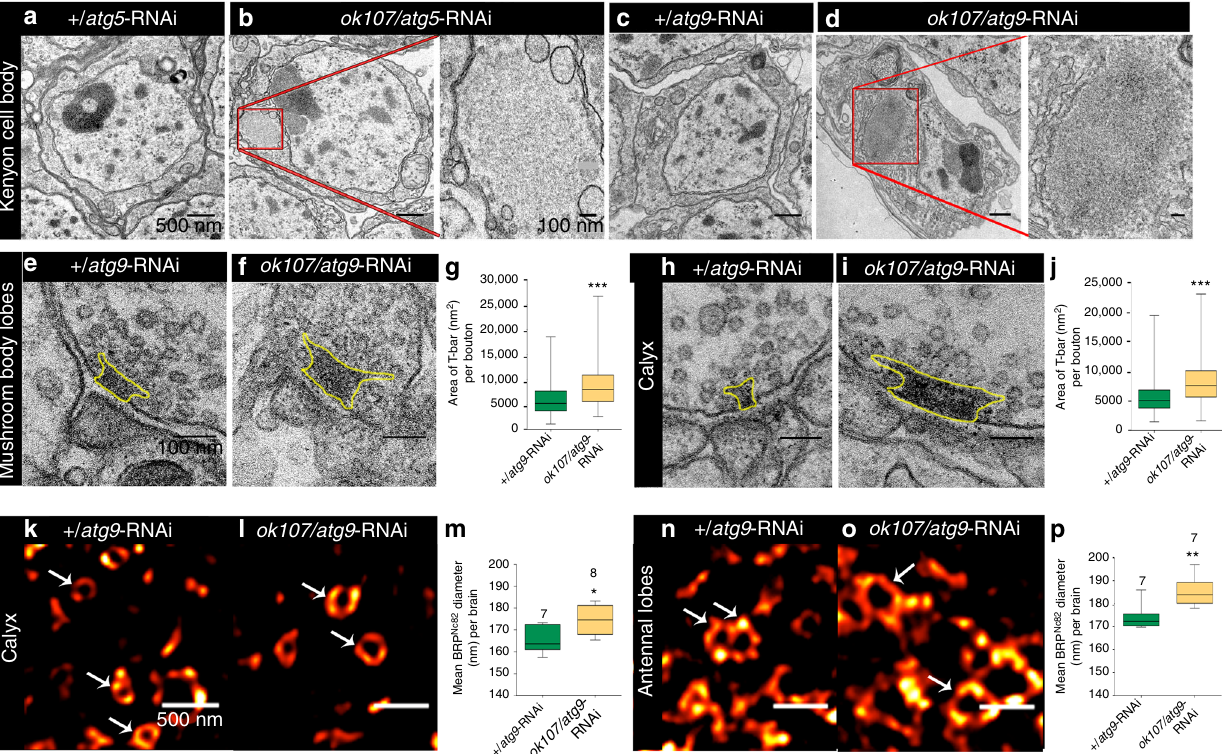
Fig. 4 Autophagy suppression in Mushroom body causes age-typical ultrastructural presynaptic phenotypes. Electron micrograph of Kenyon cell bodies in ( a ) + / atg5 -RNAi and ( b ) ok107 / atg5 -RNAi animals. Scale bar: 500 nm. Aggregates build up in ok107 / atg5 -RNAi animals (highlighted in red box). Scale bar: 100 nm. Electron micrograph of Kenyon cell bodies in ( c ) + / atg9 -RNAi and ( d ) ok107 / atg9 -RNAi animals. Scale bar: 500 nm. Aggregates build up in ok107 / atg9 -RNAi animals (highlighted in red box). Scale bar: 100 nm. Electron micrograph showing presynaptic specializations at KC-to-MBON synapses in medial MB lobes of ( e ) + / atg9 -RNAi and ( f ) ok107 / atg9 -RNAi animals (outlined as yellow). Scale bar: 100 nm. g Quanti fi cation of average T-bar size in + / atg9 -RNAi and ok107 / atg9 -RNAi animals ( n = 240 electron micrographs across 3 – 5 independent animals, with at least 20 T-bars per animals; *** p < 0.001; Mann – Whitney U -test). Electron micrograph showing presynaptic specializations at PN-to-KC synapses in Calyx of ( h ) + / atg9 -RNAi and ( i ) ok107 / atg9 -RNAi animals (outlines as yellow). Scale bar: 100 nm. j Quanti fi cation of average T-bar size in + / atg9 -RNAi and ok107 / atg9 -RNAi animals ( n = 268 electron micrographs across four independent animals, with atleast 20 t-bars per animal; *** p < 0.001; Mann – Whitney U -test). STED images of BRP spots reveal ring-shaped structures (pointed by arrowheads) within the ( k , l ) Calyx and ( n , o ) antennal lobe of + / atg9 -RNAi and ok107 / atg9 -RNAi. Scale bar: 500 nm. m Comparison of BRP ring diameter between Calyx of + / atg9 -RNAi and Calyx of ok107 / atg9 -RNAi (total of 2931 BRP rings across 16 independent animals, with at least fi ve rings per animals; * p < 0.05; Mann – Whitney U -test). p Comparison of BRP ring diameter between antennal lobe of + / atg9 -RNAi and antennal lobe of ok107 / atg9 -RNAi (total of 1327 BRP rings across 15 independent animals, with at least fi ve rings per animal; ** p < 0.01; Mann – Whitney U -test). In the box and whisker plots, the middle line of a box represents the median (50th percentile) and the terminal lines of a box represent the 25th and 75th percentile. The whiskers represent the lowest and the highest BRP signal (previously observed in ok107 / atg5 -RNAi fl ies) was no